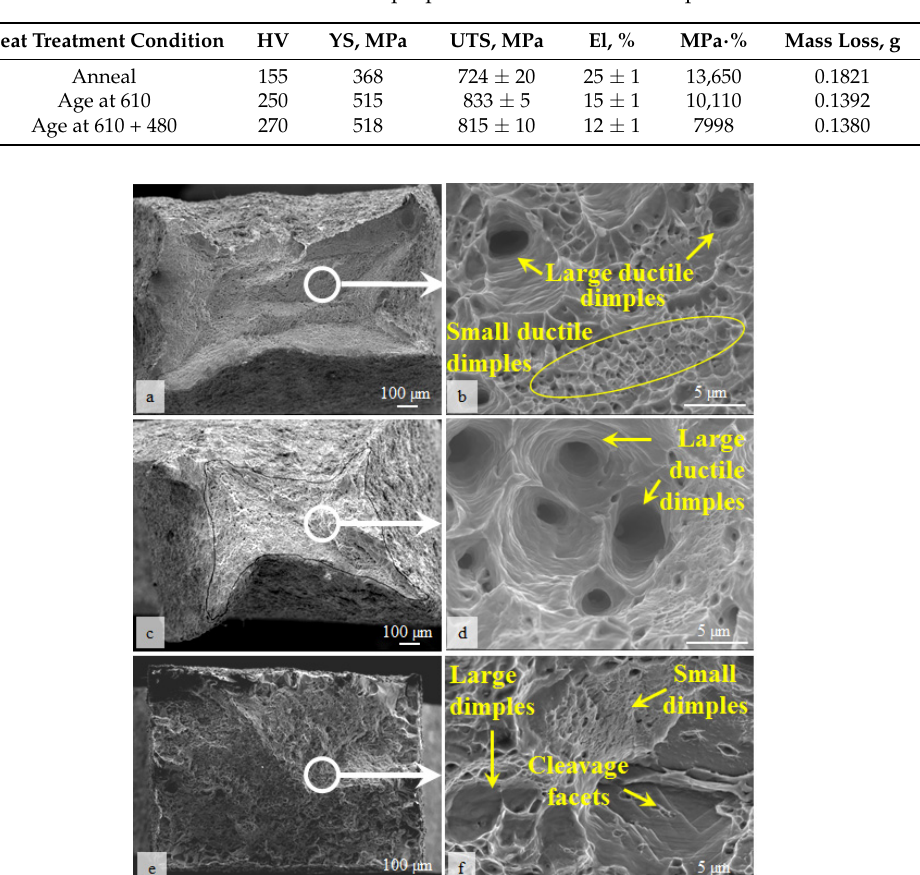
Figure 11. SEM images of the fracture surface in annealed and aged at 610 °C condition in ( a , b ) Monel K500, ( c , d ) FM60 and ( e , f ) Monel K500